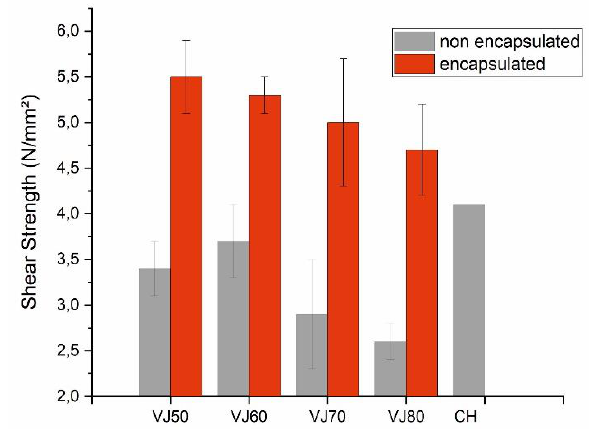
Figure 4. Shear strength of raw and encapsulated joints .